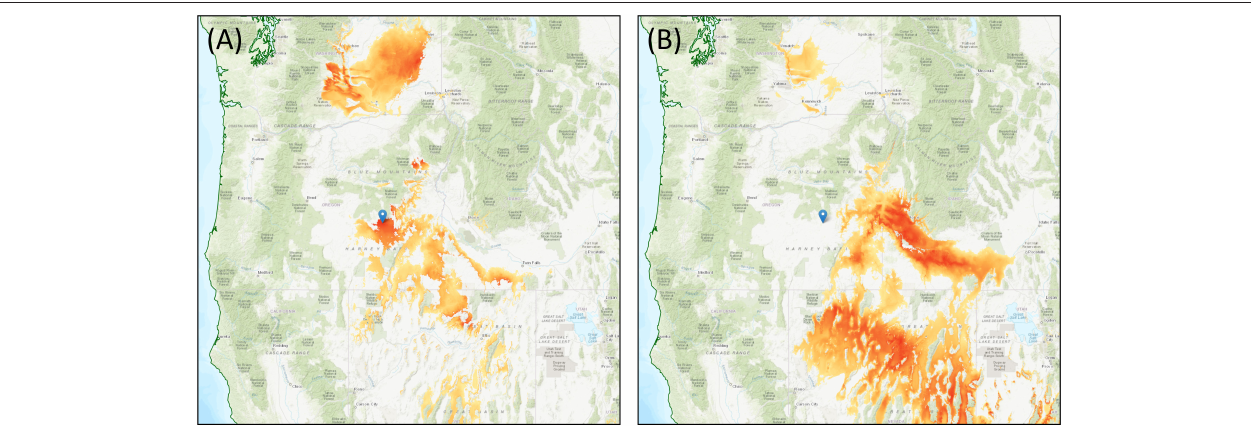
FIGURE 3 | Coupled climate, exotic species, and anthropogenic land change in sagebrush ecosystems. Big sagebrush ( Artemisia tridentata ) is a widespread and foundational species of the cold deserts in western North America. Sagebrush ecosystems in the warmest regions have been degraded or eliminated due to a combination of increased disturbance from wildfire or human activities, followed by invasion of an exotic annual grass, cheatgrass ( Bromus tectorum ). Studies have shown that sagebrush in the warmest and driest regions exhibit low resistance and resilience to disturbance and landscapes are frequently transformed to cheatgrass dominated ecosystems ( Chambers et al., 2007, 2014). Climatic niche modeling of cheatgrass (Bradley et al., 2016), big sagebrush (Still and Richardson, 2015), and plant community biomes ( Rehfeldt et al., 2012), as well as trends vegetative cover (Shi et al., 2018) suggest that the low resilience and resistance of sagebrush in these areas are linked to climate; transformation to cheatgrass in these warmer regions is likely not only caused by increased disturbance, but confounded by a shifting climate. For vulnerable areas, efforts to restore sagebrush could be futile due to abundance of cheatgrass coupled with disturbance regimes and unfavorable climatic regimes for sagebrush establishment. Ultimately, investing in the research that can aid in decision support can pay dividends by focusing restoration efforts where they would be most effective. For example, a decision support tool, the Climate Smart Restoration Tool (CSRT), is being developed that integrate correlative, climatic niche models, and mechanistic trait-based seed transfer models ( Richardson and Chaney, 2018). The CSRT maps seed transfer limits based on the genetic adaptation to climates. Managers can develop maps for current and potential future climates using models that reflect differing scenarios of green house gas emissions. Seed transfer limits for a big sagebrush site in southeast Oregon, USA. Map (A) shows seed transfer areas for a contemporary climate (1981–2010) and map (B) shows mid-century climates (2041–2070). The colored gradient, with increasing climatic similarity from yellow to red, shows areas where seed collections would be suitable for the restoration site (blue pin). Note by mid-century local seed sources are no longer suitable and seed must be obtained from warmer, lower elevation sites (B)